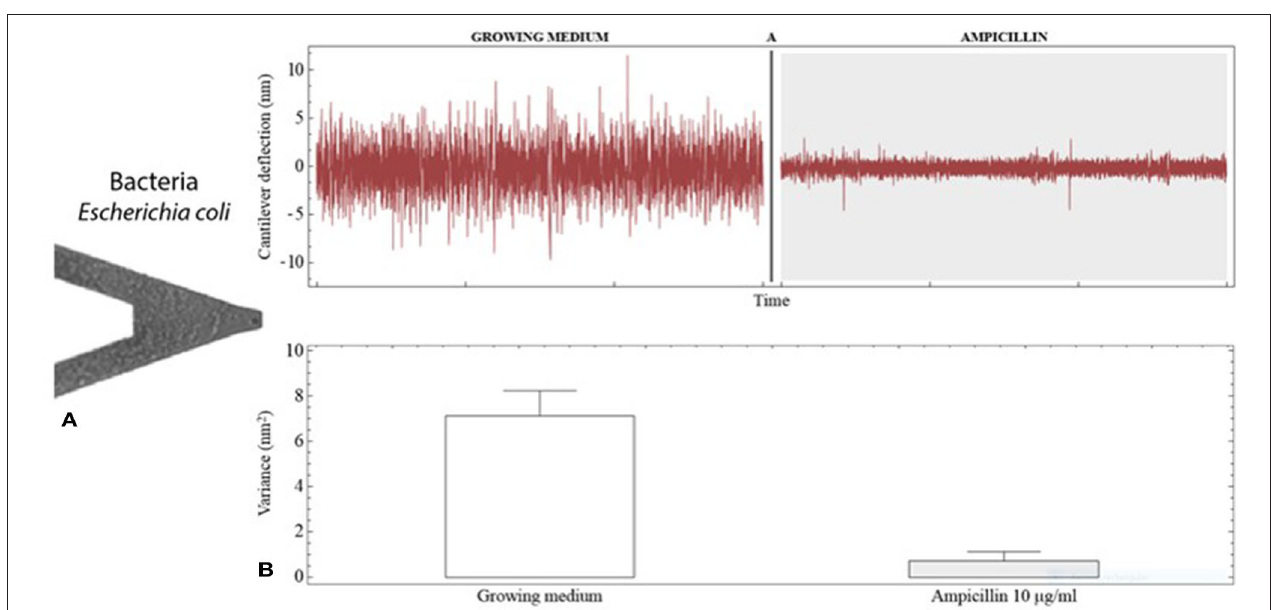
FIGURE 6 | Antibiotic susceptibility testing with nanomechanical sensors. (A) SEM image of a V-shaped cantilever coated with E. coli cells. (B) Deflection fluctuations of the cantilever when exposed to growing medium and to growing medium containing the antibiotic ampicillin. The cantilever fluctuations are notably reduced by the antibacterial activity of the drug as can be noticed by changes in the signal variance. Reprinted from Kasas et al. (2015) with permission from the National Academy of Sciences of the United States of America.